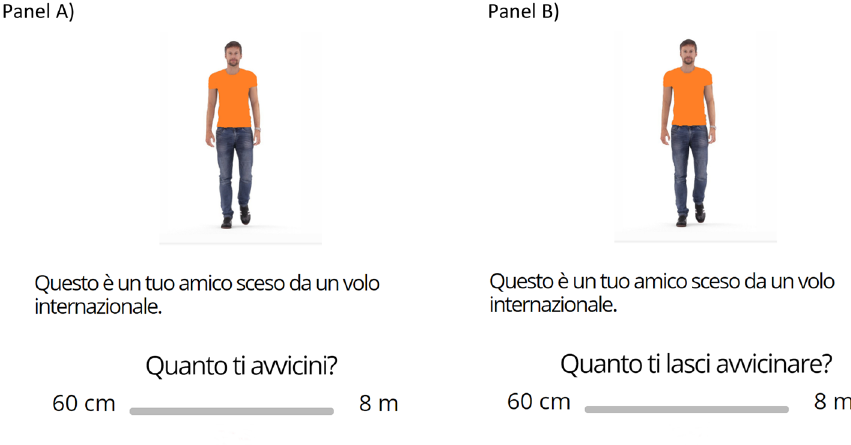
Figure 1. ( A ) Example of the “Active” physical-distancing practice from the avatar through a visual analog 60 cm–8 m scale (VAS); ( B ) Example of the “Passive” physical-distancing practice from the avatar through a visual analog 60 cm–8 m scale